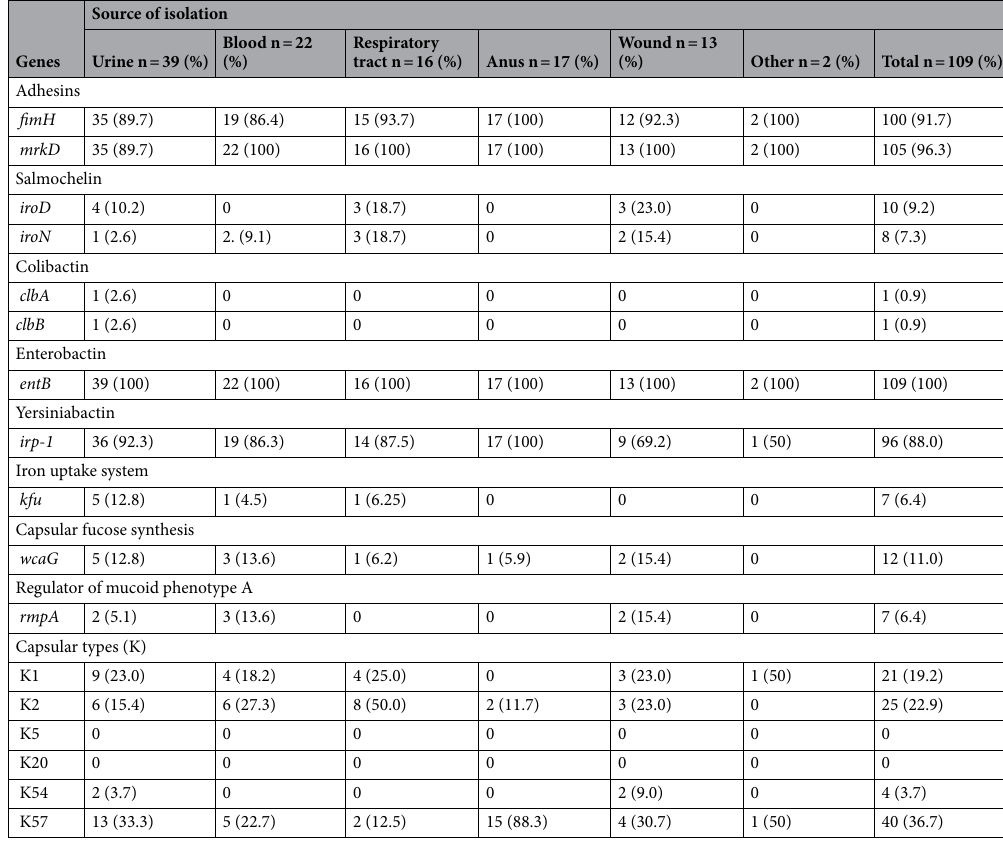
Table 4. The prevalence of virulence-associated genes in K. pneumoniae isolates from different clinical